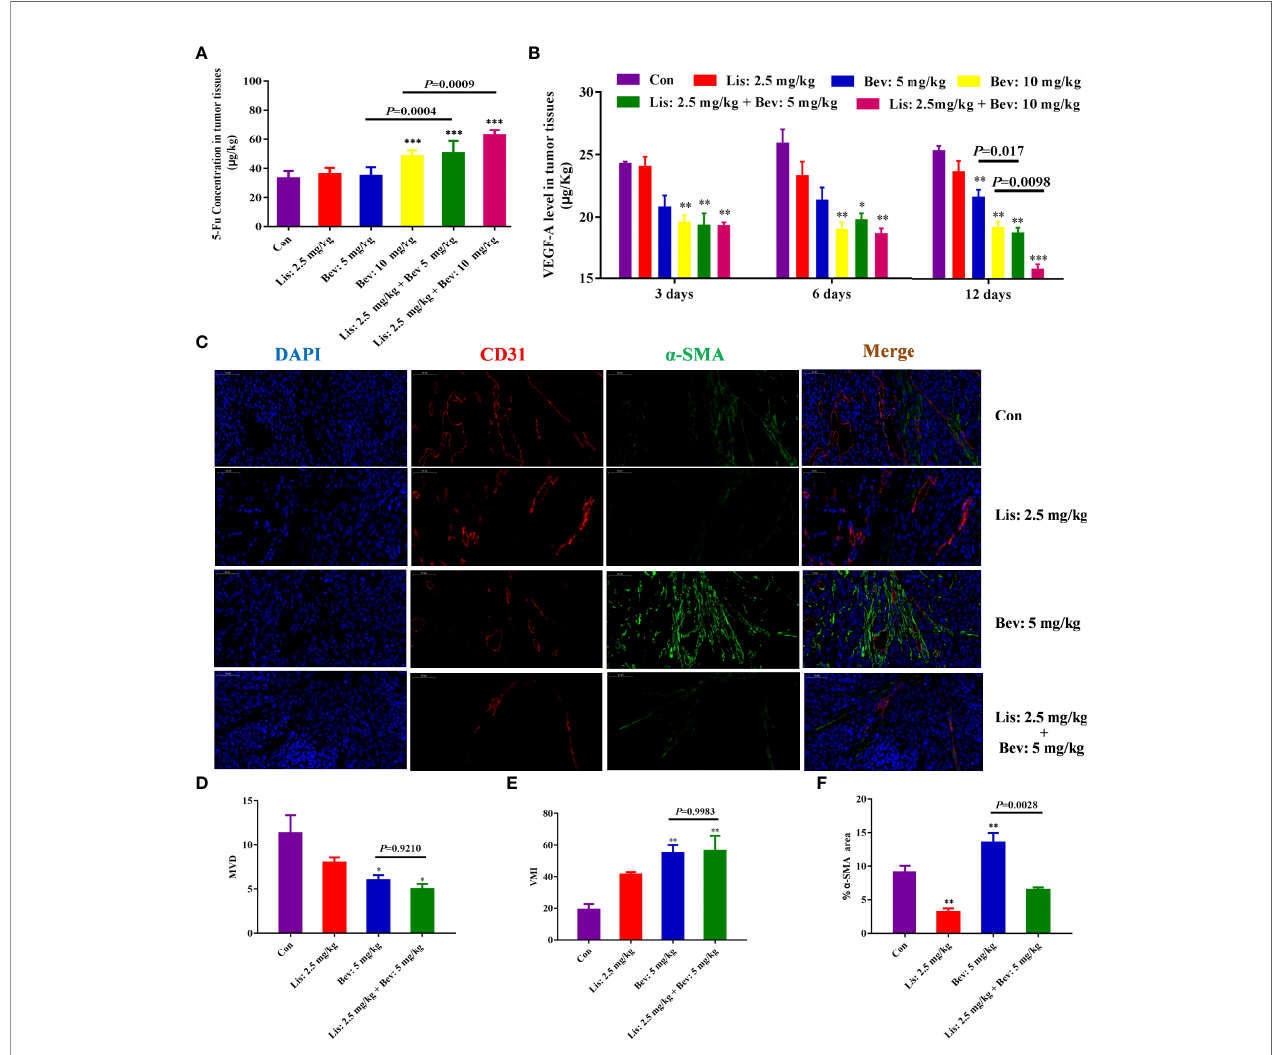
FIGURE 3 | Synergistic effects of Bev and Lis on 5-Fu tissue penetration and angiogenesis in HCT116 xenografts. (A) Synergistic effect of Bev and Lis on 5-Fu concentration in tumor tissues (n = 6). (B) VEGFA levels in tumor tissues at 3, 6, and 12 days after Lis and Bev administration. (C) Immuno fl uorescence staining images of CD31 and a -SMA (Scale bar = 50 m m). (D) The effects of Bev and Lis on MVD. (E) The effects of Bev and Lis on VMI. (F) The proportions of a -SMA- positive areas were quanti fi ed using ImageJ software. Data represent the mean ± SEM. * P < 0.05, ** P < 0.01, *** P < 0.001 versus the control group. Con, control; Bev, bevacizumab; Lis, lisinopril; 5-Fu, 5- fl uorouracil; VEGFA, vascular endothelial growth factor A; MVD, microvessel density; VMI, vascular maturity